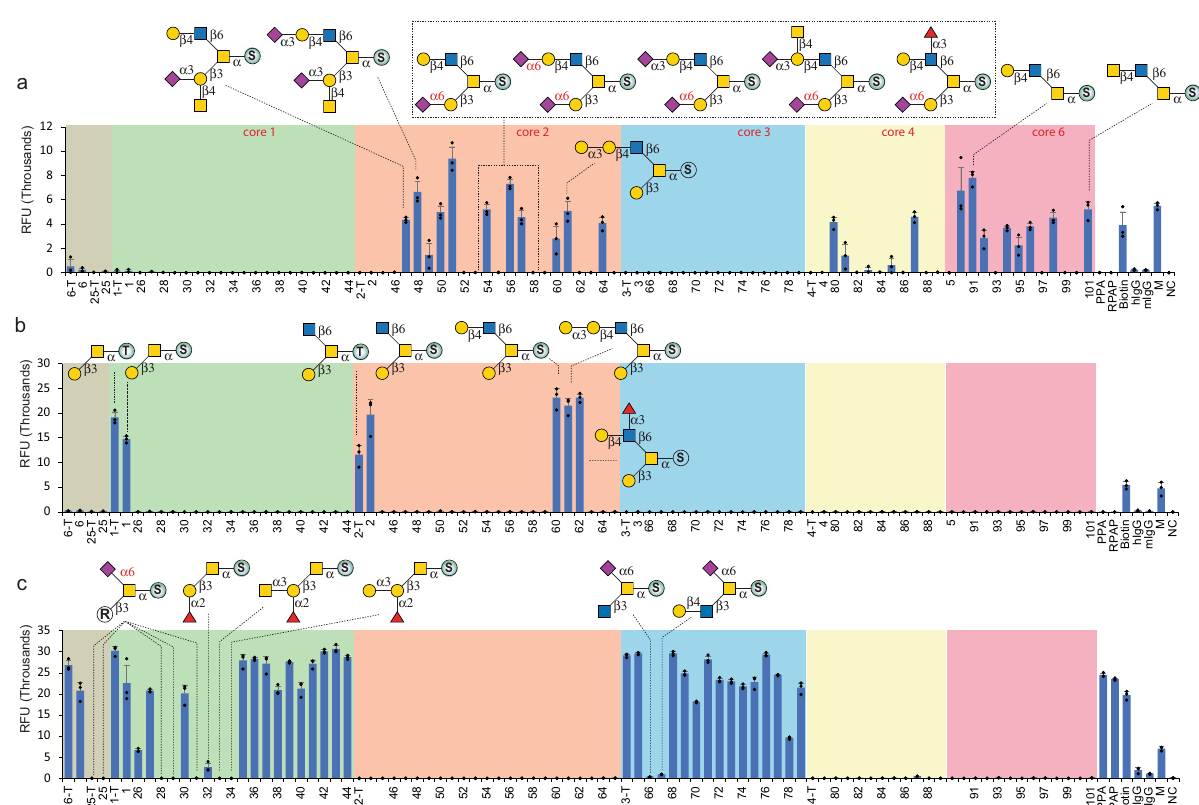
Fig. 6 Binding pro fi les of lectins towards O-GalNAc glycans. a The binding pro fi le of STL towards O-GalNAc glycans. b The binding pro fi le of PNA towards O-GalNAc glycans. c The binding pro fi le of Jacalin towards O-GalNAc glycans. The x -axis shows glycans, and the y -axis shows relative fl uorescence readout using Cy5-streptavidin (1 μ g/mL). PPA = APGS(GalNAc α -)TAPP (100 µ M); RPAP = TSAPD(GalNAc α -)TRPAP (100 µ M); x-T, Thr-linked counterparts of Ser-linked O-glycans; Biotin = biotinylated PEG amine (0.01 mg/mL); hIgG = human IgG (0.1 mg/mL), mIgG = mouse IgG (0.1 mg/mL); M = Marker (0.01 mg/mL Cy3-conjugated anti-Human IgG + 0.01 mg/mL Alexs647-conjugated anti-Human IgG); NC = printing buffer negative control. n = 3 independent replicates. The individual data points are shown as dots. Data are presented as mean values. Error bars represent standard deviation. Source data are provided as a Source Data fi